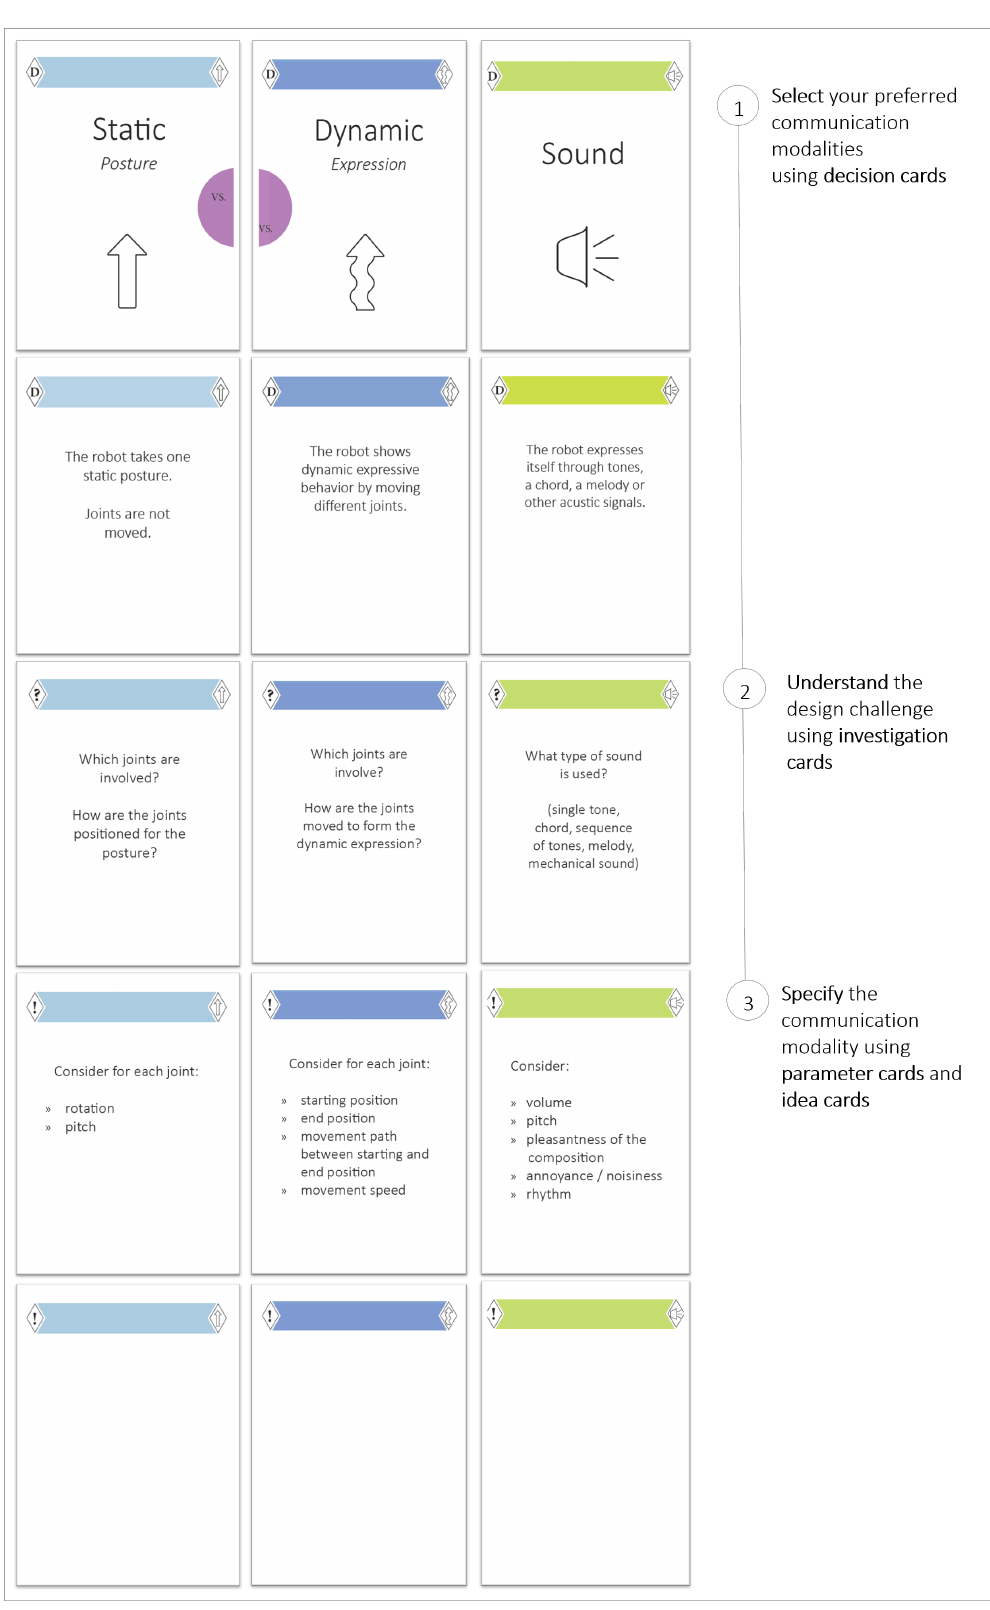
Figure 2. The set of decision cards (<D>) (front: First row, back: Second row), investigation cards (front: Third row) (<?>), parameter cards (front: Fourth row), and idea cards cards (front: Fifth row) (<!>) for the examples “Static Posture”, “Dynamic Expression”, and “Sound” (left) and the three steps of the design process